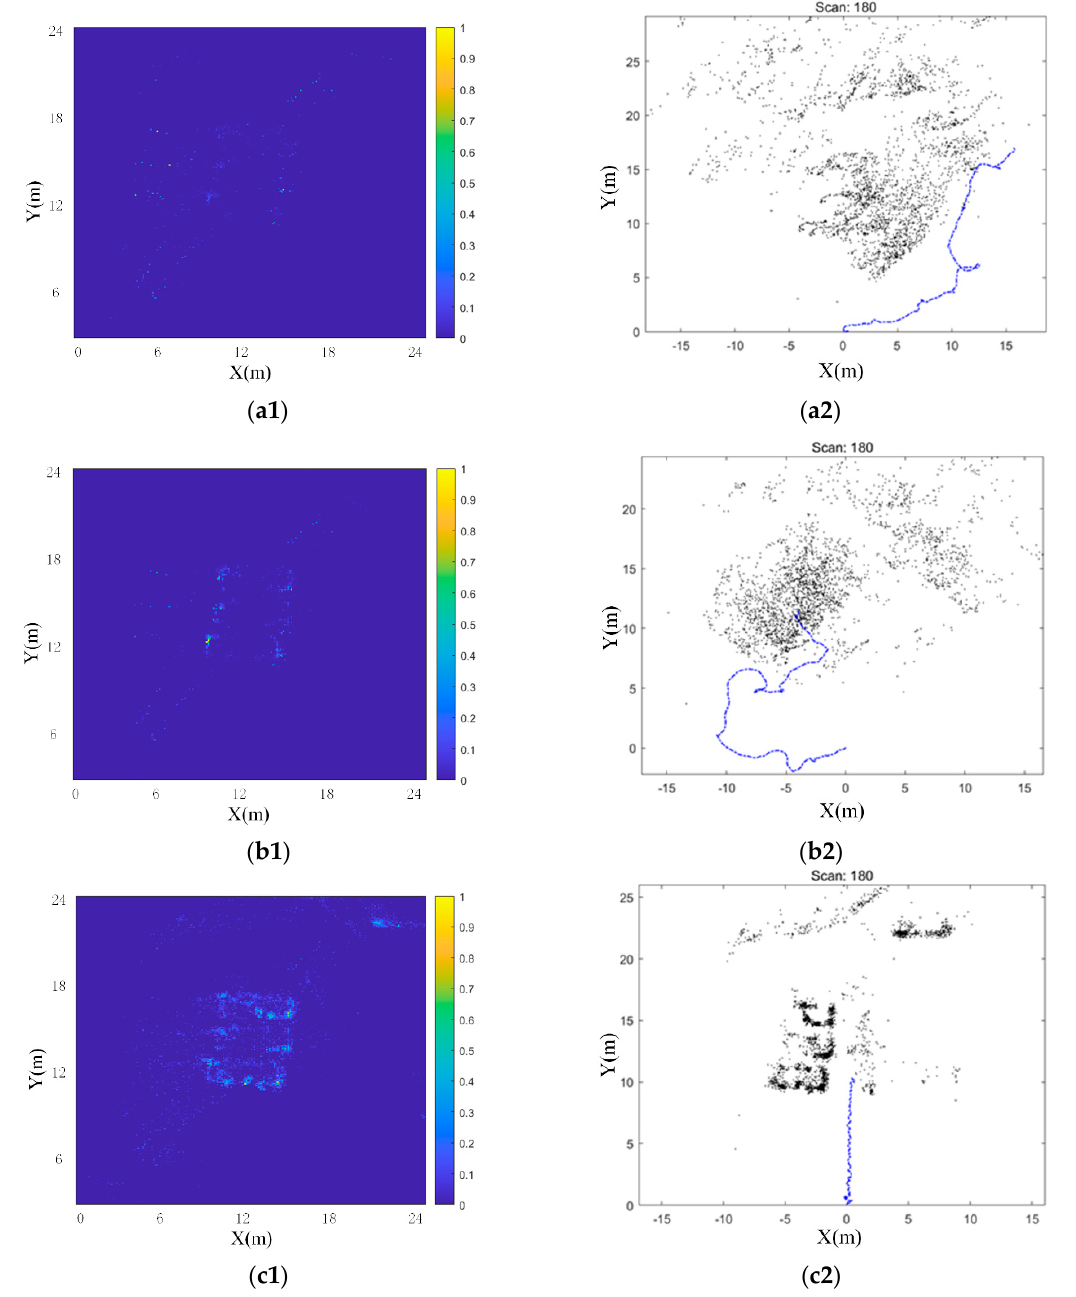
Figure 13. The maps and trajectories generated by the three improved CSM methods combining RCS features. ( a1 – c1 ) Maps generated by three methods. The three maps correspond to different physical quantities. ( a1 ) corresponds to the RCS of the target, ( b1 ) corresponds to the echo power of the target, and ( c1 ) corresponds to the existence probability of the target. The dark blue corresponds to the minimum value of the physical quantity, and the light yellow corresponds to the maximum value of the physical quantity. ( a2 – c2 ) Trajectories generated by the three methods when only 180 frames of data are used. The blue line is the radar trajectory, and the black point is the radar point cloud.